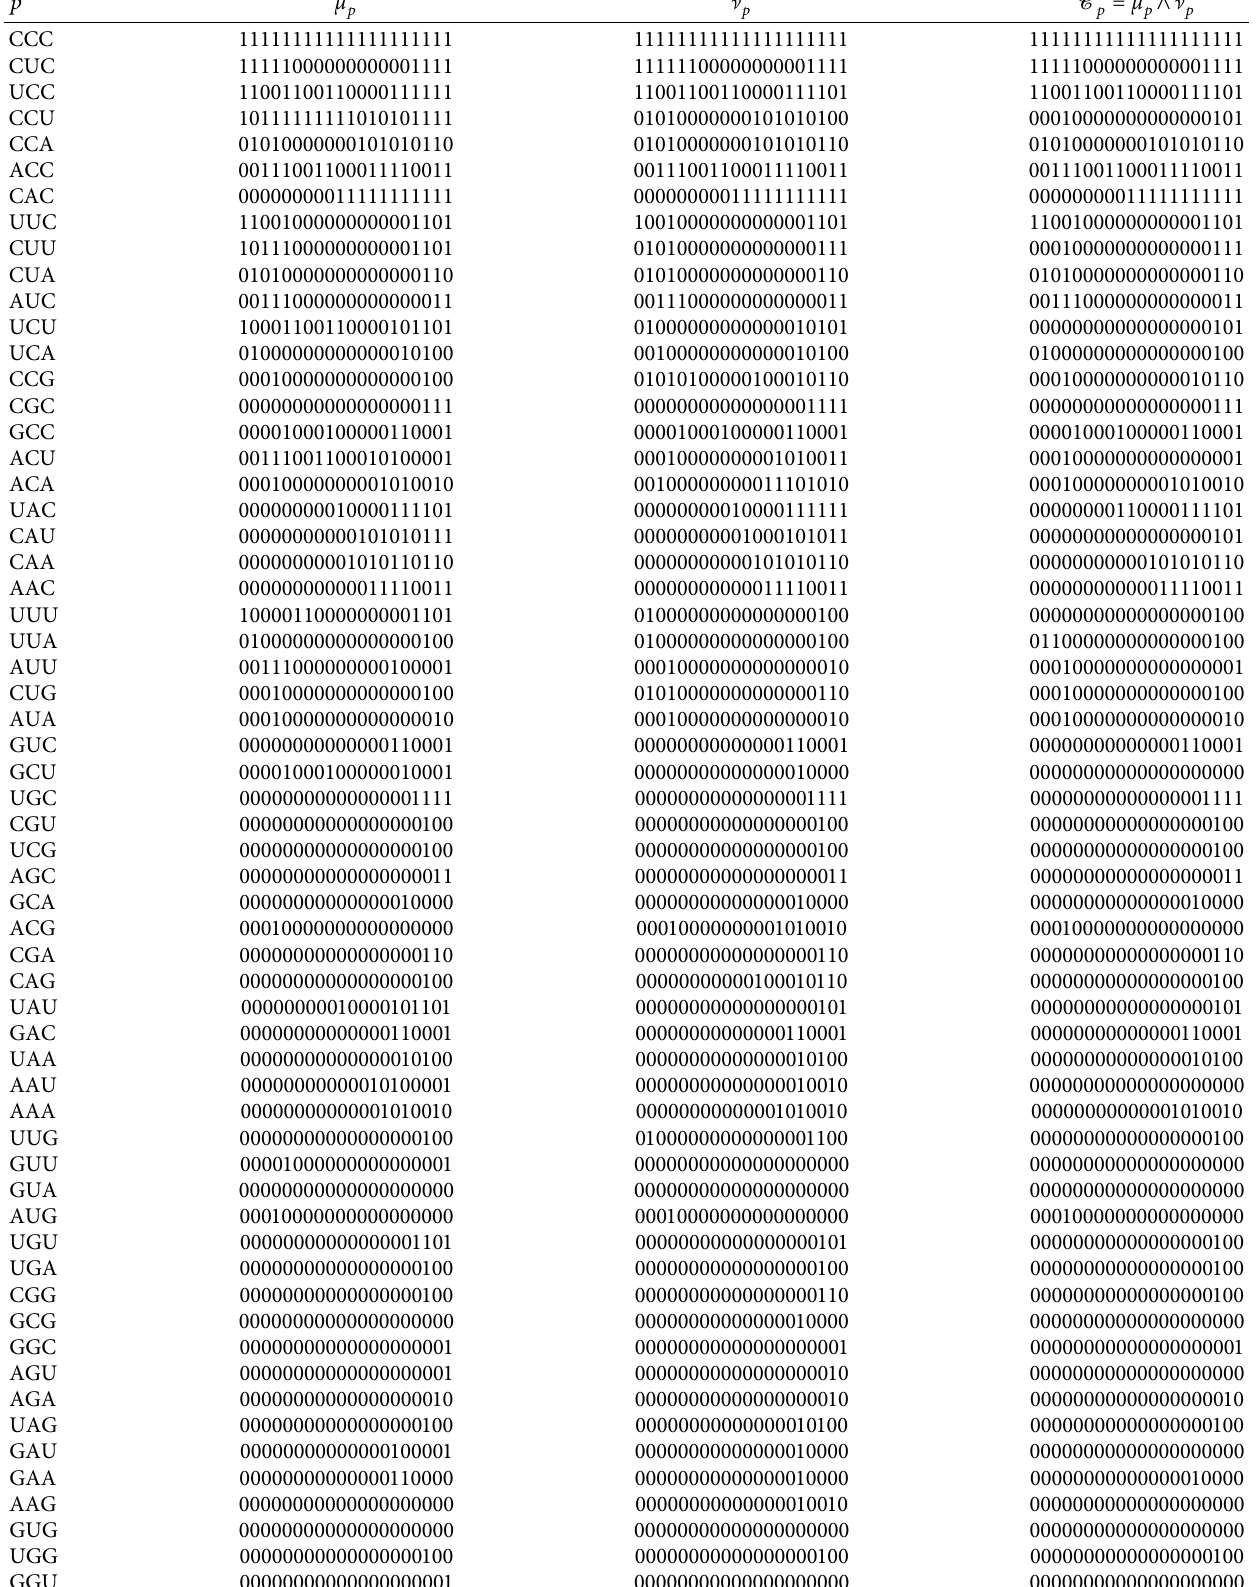
Table 4: Genetic codes over